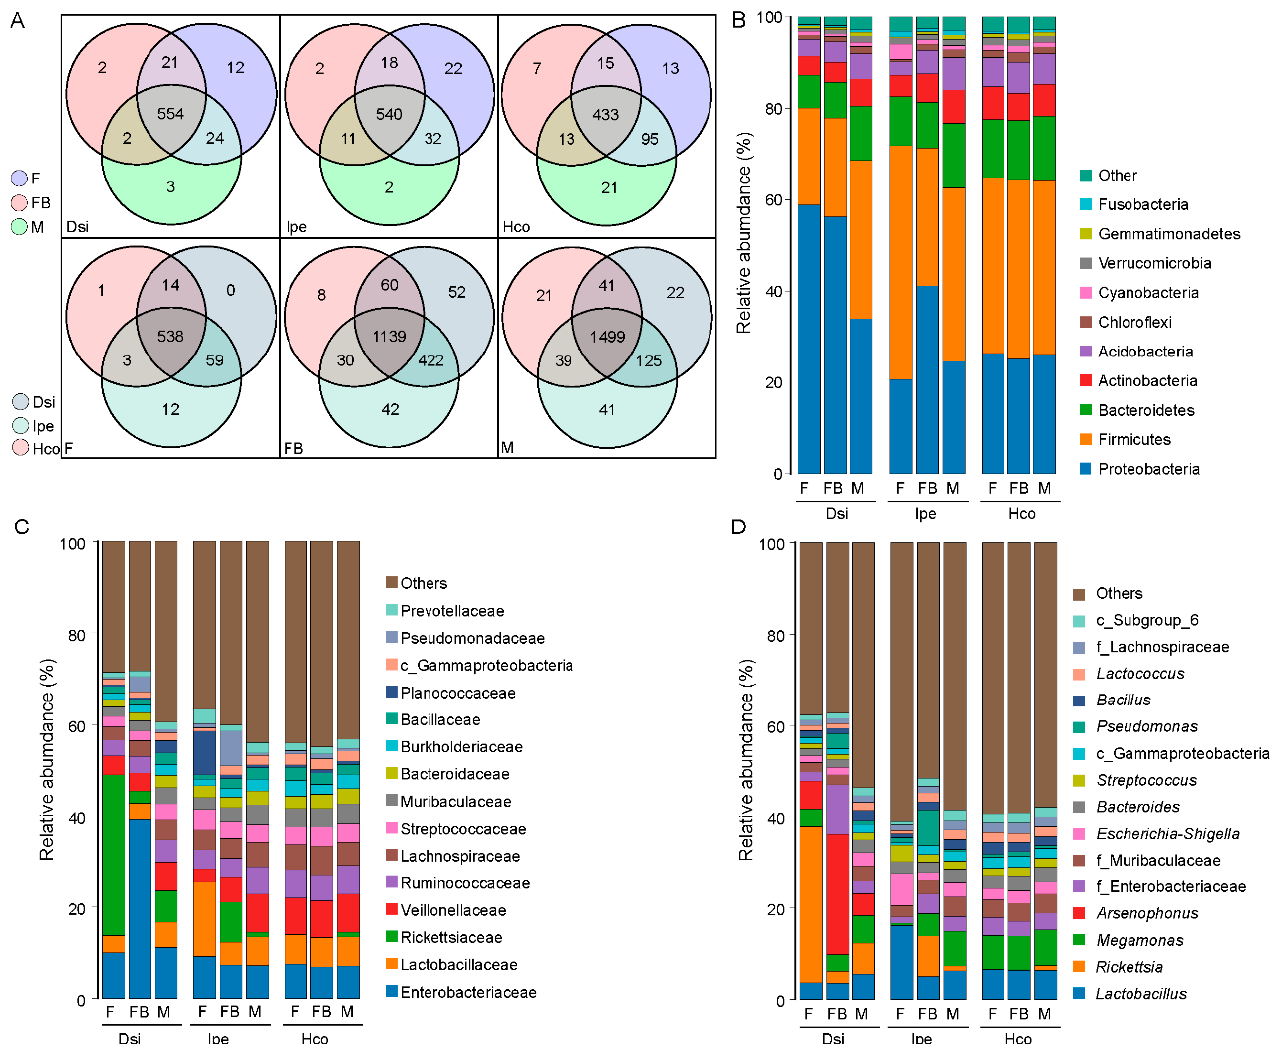
Figure 3. Common and differentially abundant bacteria (different level) within ticks. Venn diagram showing number of common bacterial genera between tick groups and species ( A ). Histogram of species distribution at different taxonomic levels ( B – D ). Notes: F, female; FB, full of blood (engorged); M, male; Dsi, Dermacentor silvarum ; Ipe, Ixodes spersulcatus ; Hco, Haemaphysalis concinna .